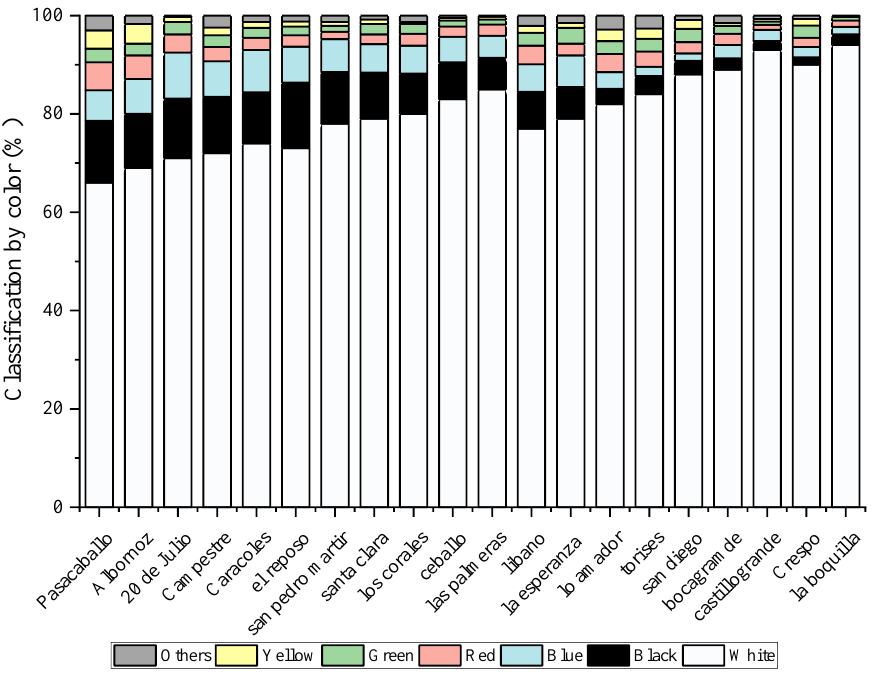
Figure 1. MP composition by color.